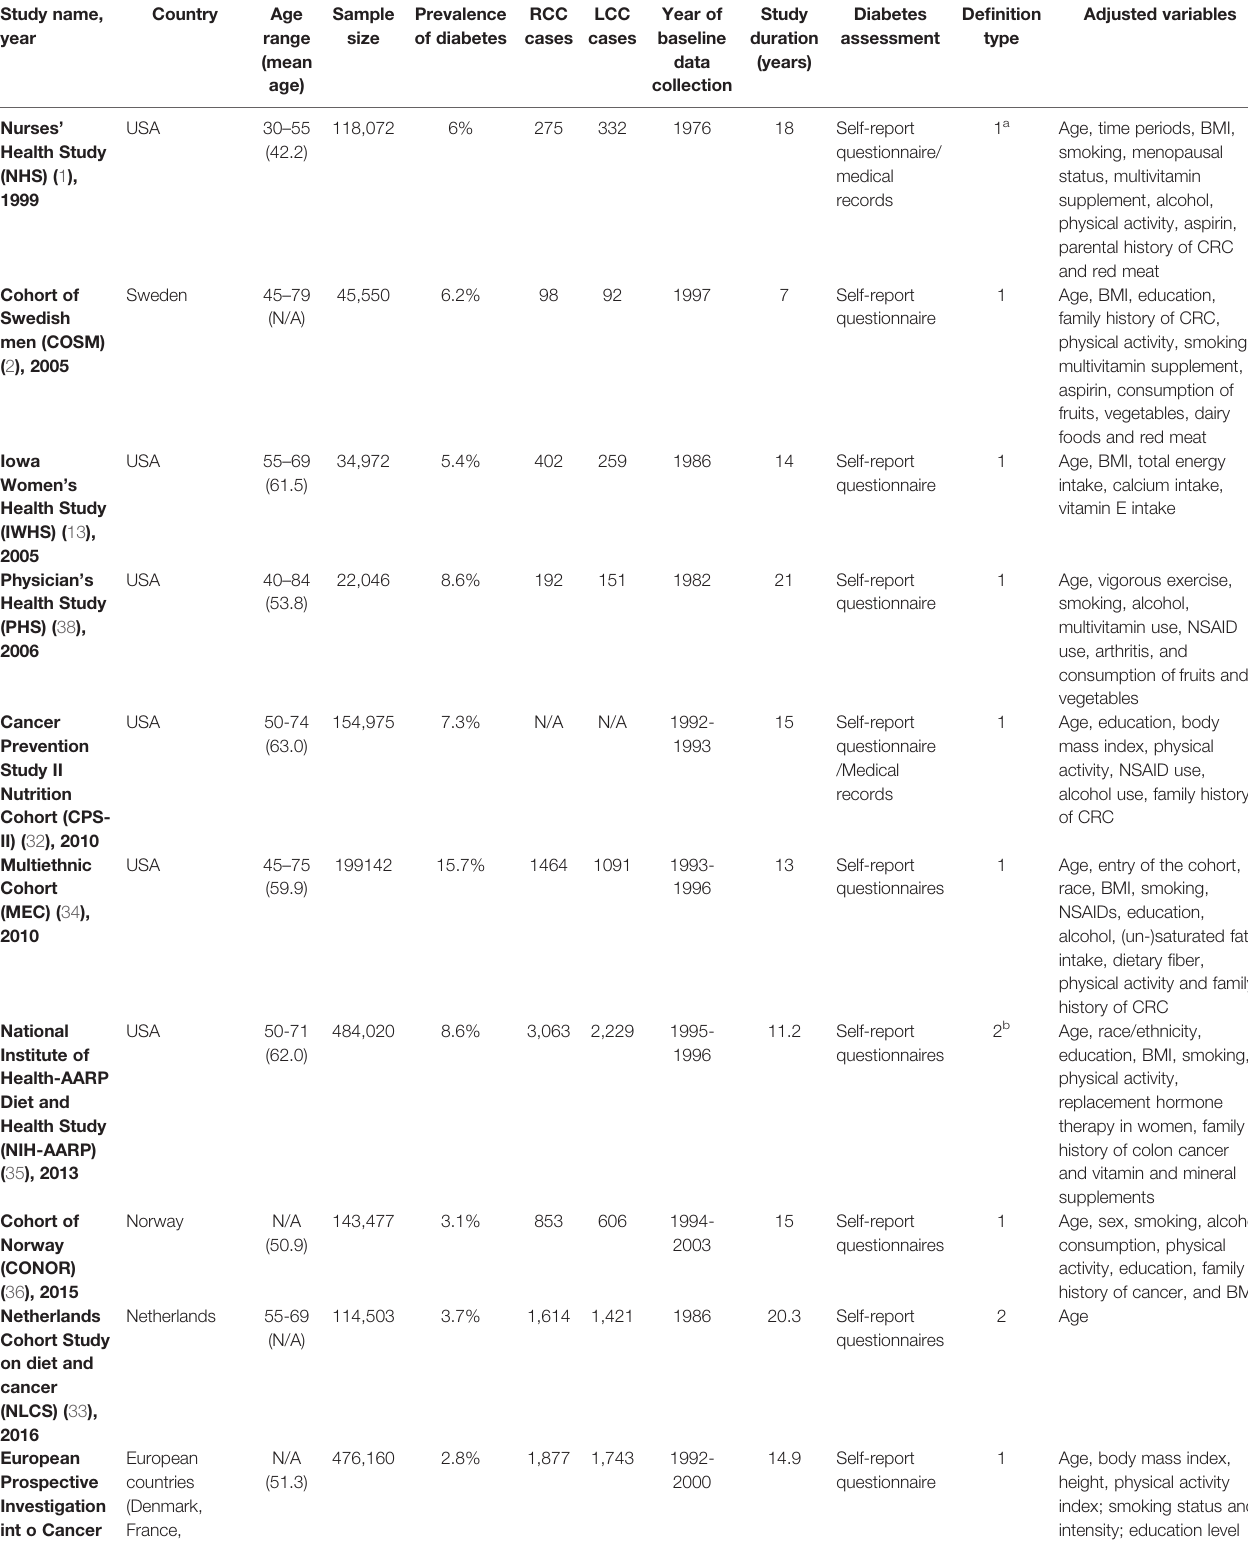
TABLE 1 | Characteristics of included